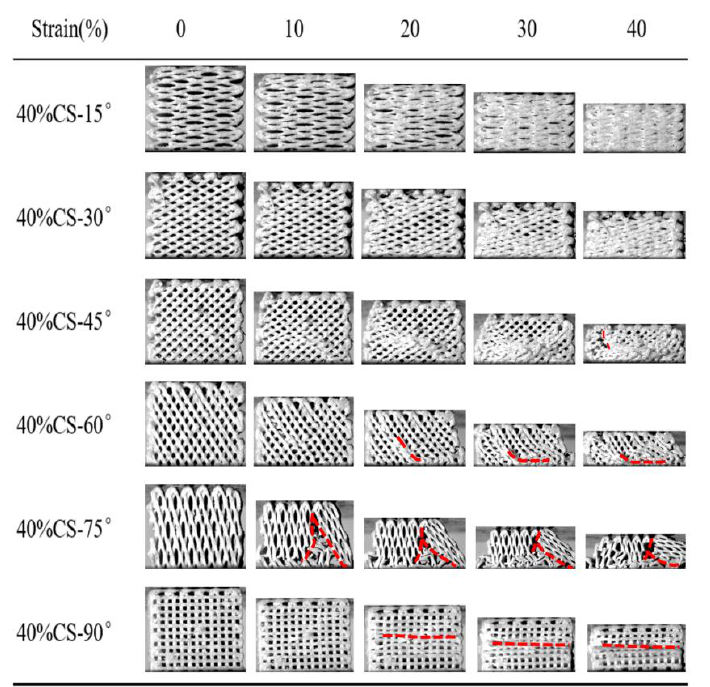
Figure 7. The compressive process of the 40%CS scaffolds with different raster angles.